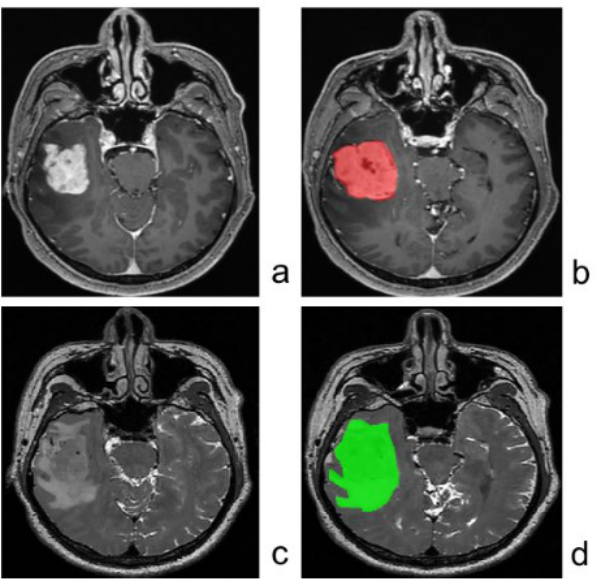
Figure 2. Process of delineating the ROI. The ROIs of the tumor parenchyma (red area) were delineated by manually tracing contrast-enhancing lesions on T1CE ( a , b ). The ROIs of whole tumors (green area), including the parenchyma and edema, were delineated by manually tracing high-intensity lesions on T2WI ( c , d ).